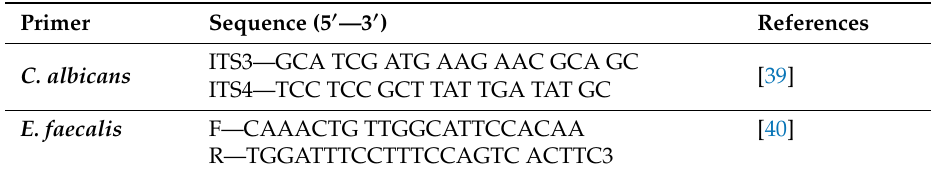
Table 3. C. albicans and E. faecalis primers for